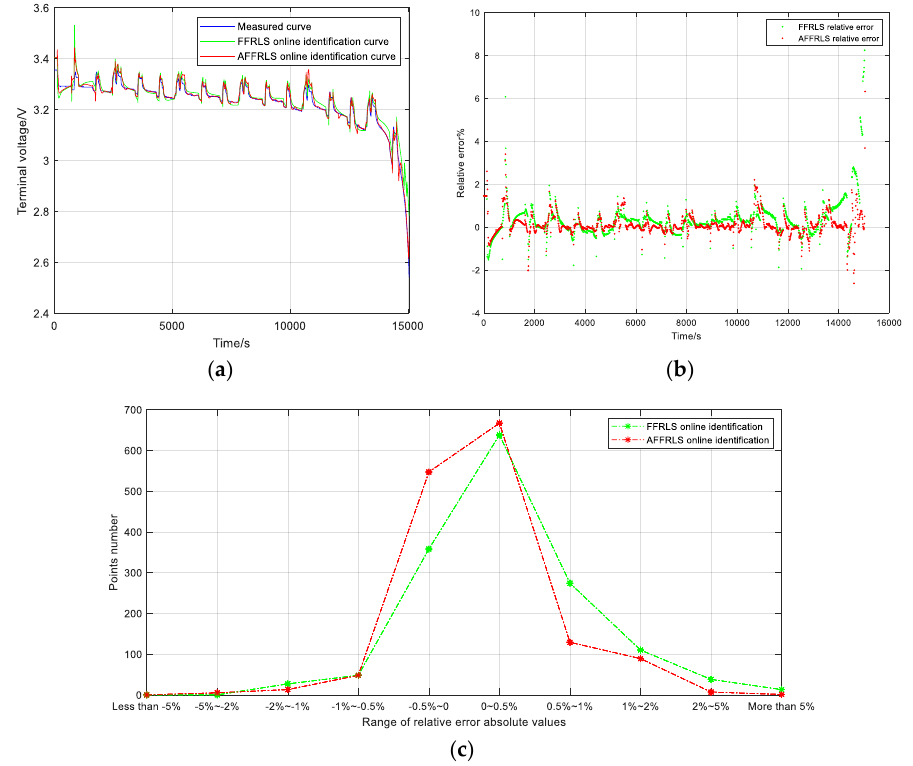
Figure 11. Comparison of the measured terminal voltage and the terminal voltage identified by the FFRLS and AFFRLS algorithms: ( a ) Terminal voltage comparison curve; ( b ) Scatter plots of relative errors; ( c ) Distribution statistics of relative errors.